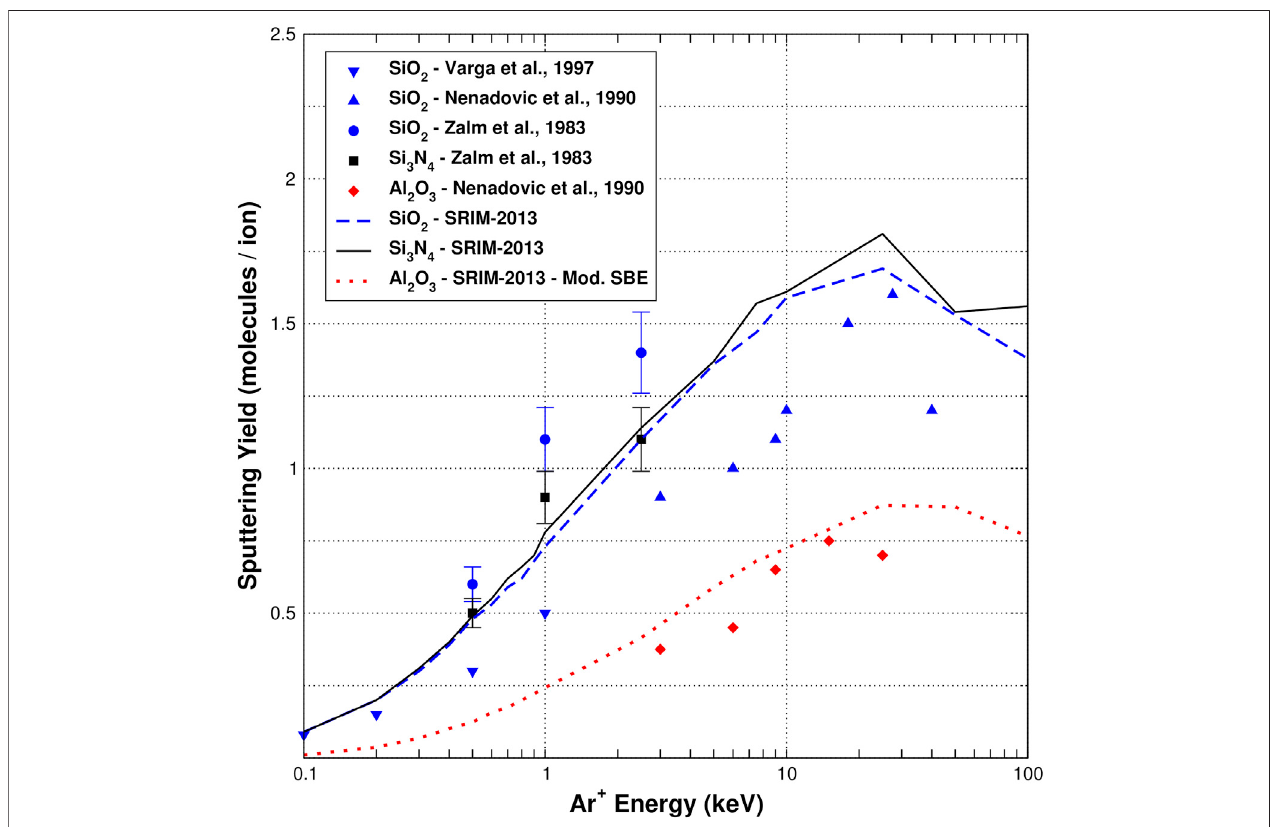
FIGURE7| SputteringyieldsforAr + ionsimpactingperpendicularlyontosomeofthecompoundscommonlyusedintheconstructionofHPSs.Experimentaldatais shown for SiO 2 [92 – 94], Al 2 O 3 [93], and Si 3 N 4 [92]; as well as computational results obtained with the SRIM-2013 package.